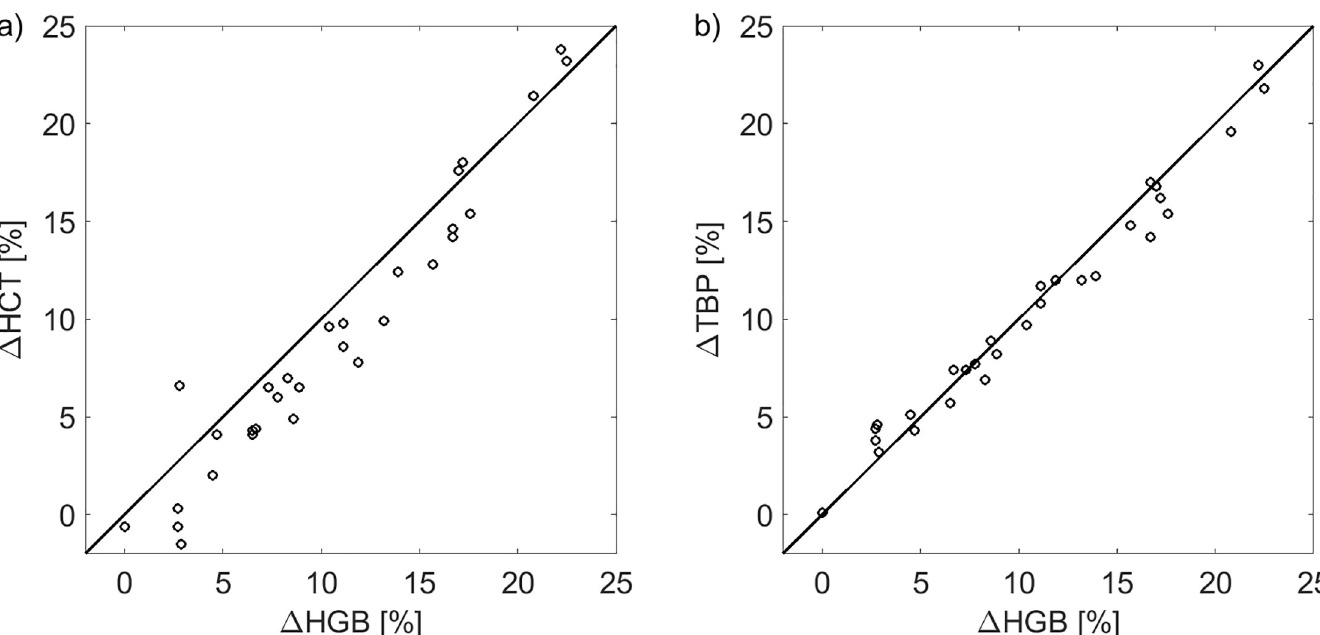
Hemodialysis-inducedchangesin haematocrit, haemoglobinand total protein